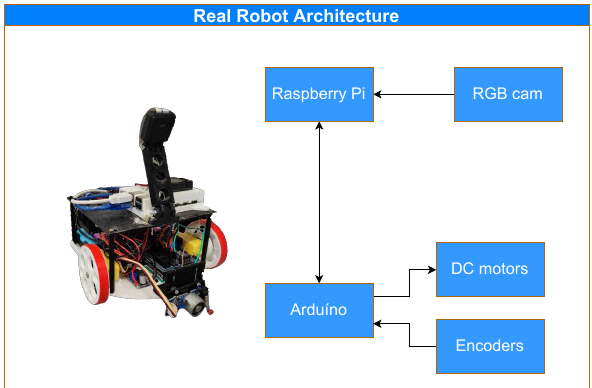
Figure 3. Robot architecture. It is composed of two main micro-controllers: the Raspberry Pi is responsible for the decision-making process and the control of the RGB camera; the Arduino is responsible for the other physical parts, such as the motors and